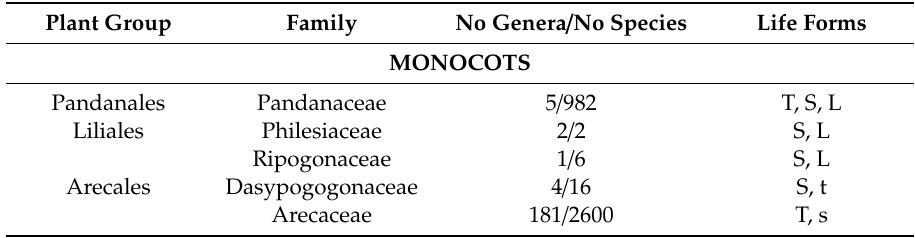
Table A2. List of monocot plant families composed entirely of tree-, shrub- and liana-like organisms